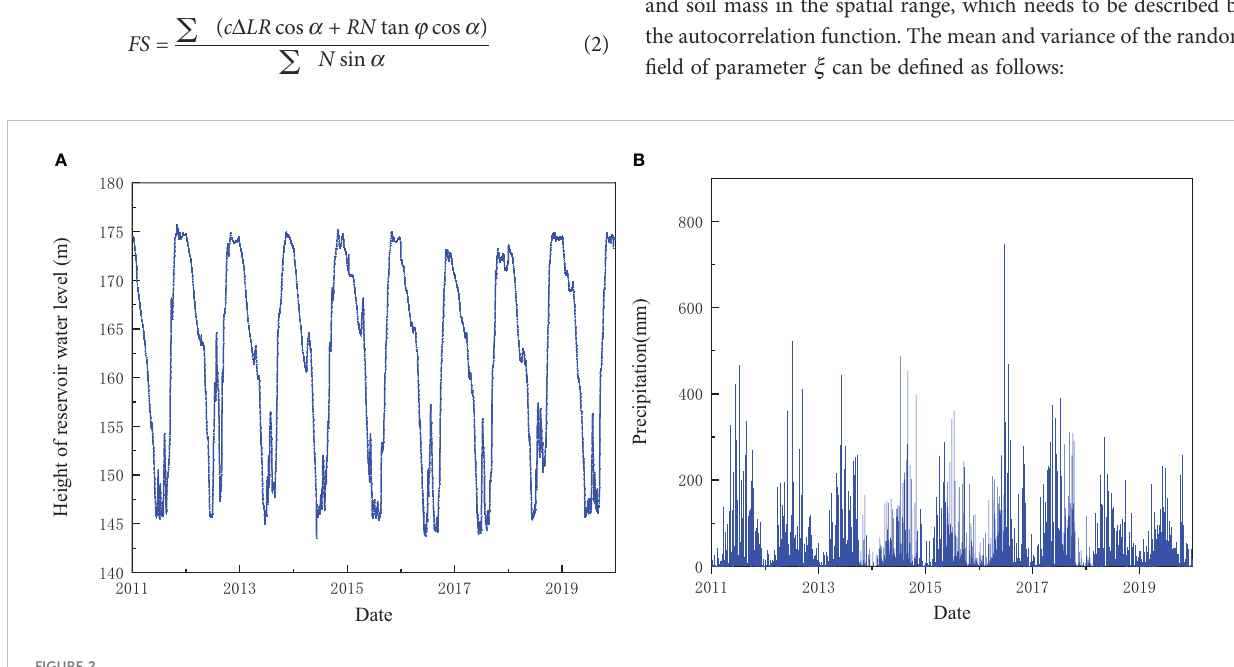
FIGURE 2 The factors affecting the seepage fi eld of the bank landslide. (A) The reservoir water level of Three Gorges Reservoir; (B) Daily precipitation of Badong